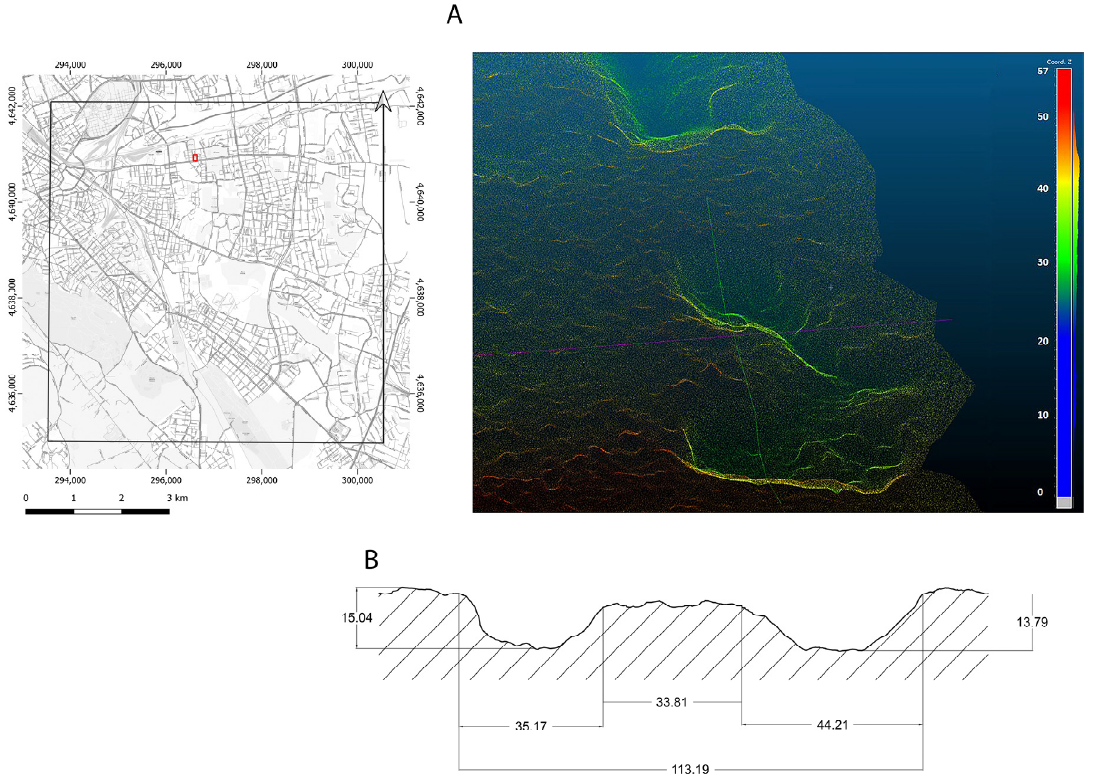
Figure 11. ( A ) 3D visualization of the DSM and classification of the height in color ramps; ( B ) extraction and rendering of a profile (line in green) that clearly shows a central swelling, interpreted as the pillar or a wall. On the left side, the localization of the structure within the AOI border (red